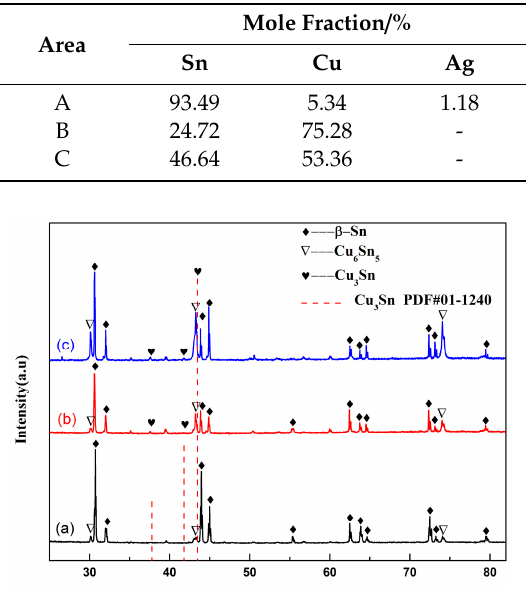
Table 1. EDS analysis results of the “A”, “B”, and “C” areas in Figure 13.